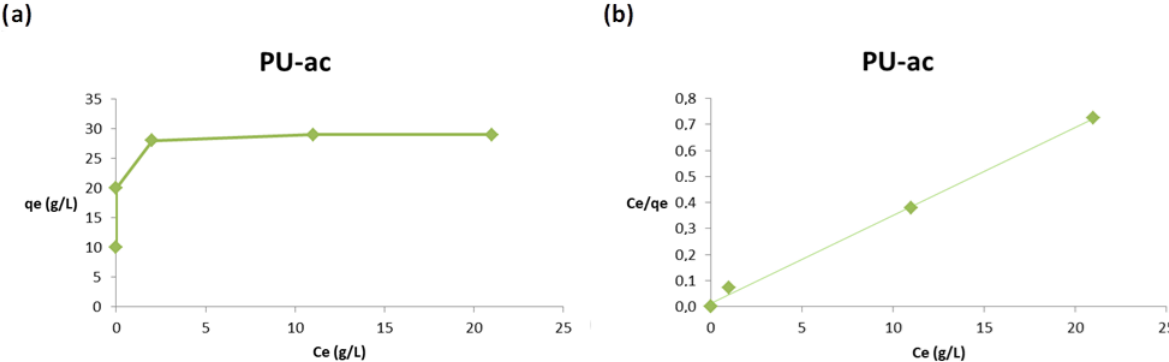
Figure 10. ( a ) Effect of the initial concentration on the adsorption capacity, q, ( b ) Langmuir